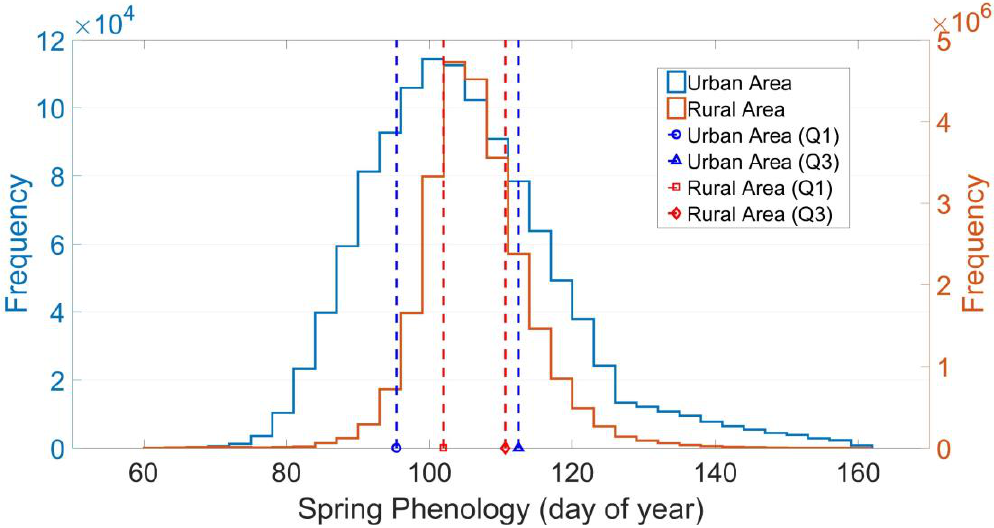
Figure 10. Frequency histogram of vegetation spring phenology at spatial resolution (10m).